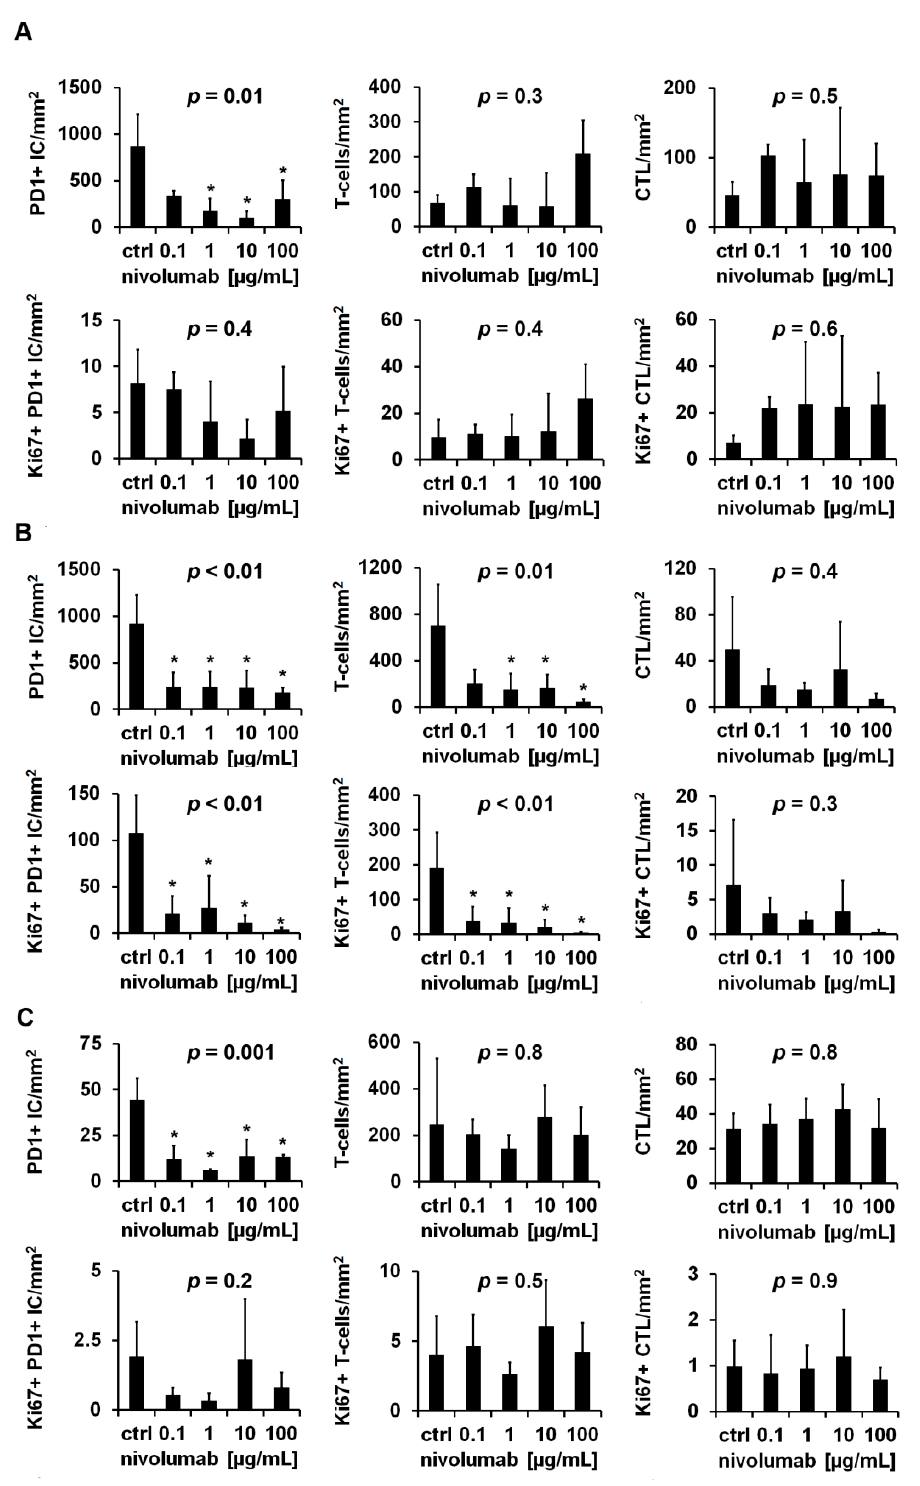
Figure 4. Nivolumab-dependent changes of tumor infiltrating immune cell densities and proliferation rates. Tissue slices of clear cell renal cell carcinoma (ccRCC) were immunohistochemically stained for Ki67-PD1, Ki67-CD3, and Ki67-CD8 after 24 h of cultivation with increasing concentrations of nivolumab. Three representative reaction patterns to nivolumab treatment are shown: ( A ) pattern A (tumor 3) with nivolumab-dependent increased tumor infiltrating T-cells, ( B ) pattern B (tumor 5) with nivolumab-dependent decreased tumor infiltrating T-cells, and ( C ) pattern C (tumor 7) without nivolumab- dependent changes of tumor infiltrating T-cells. Data are given as mean ± standard deviation. For statistical analysis the one-way analysis of variance or the Kruskal–Wallis test with appropriate post hoc tests were used. p -values were corrected with the Bonferroni method. *: p <